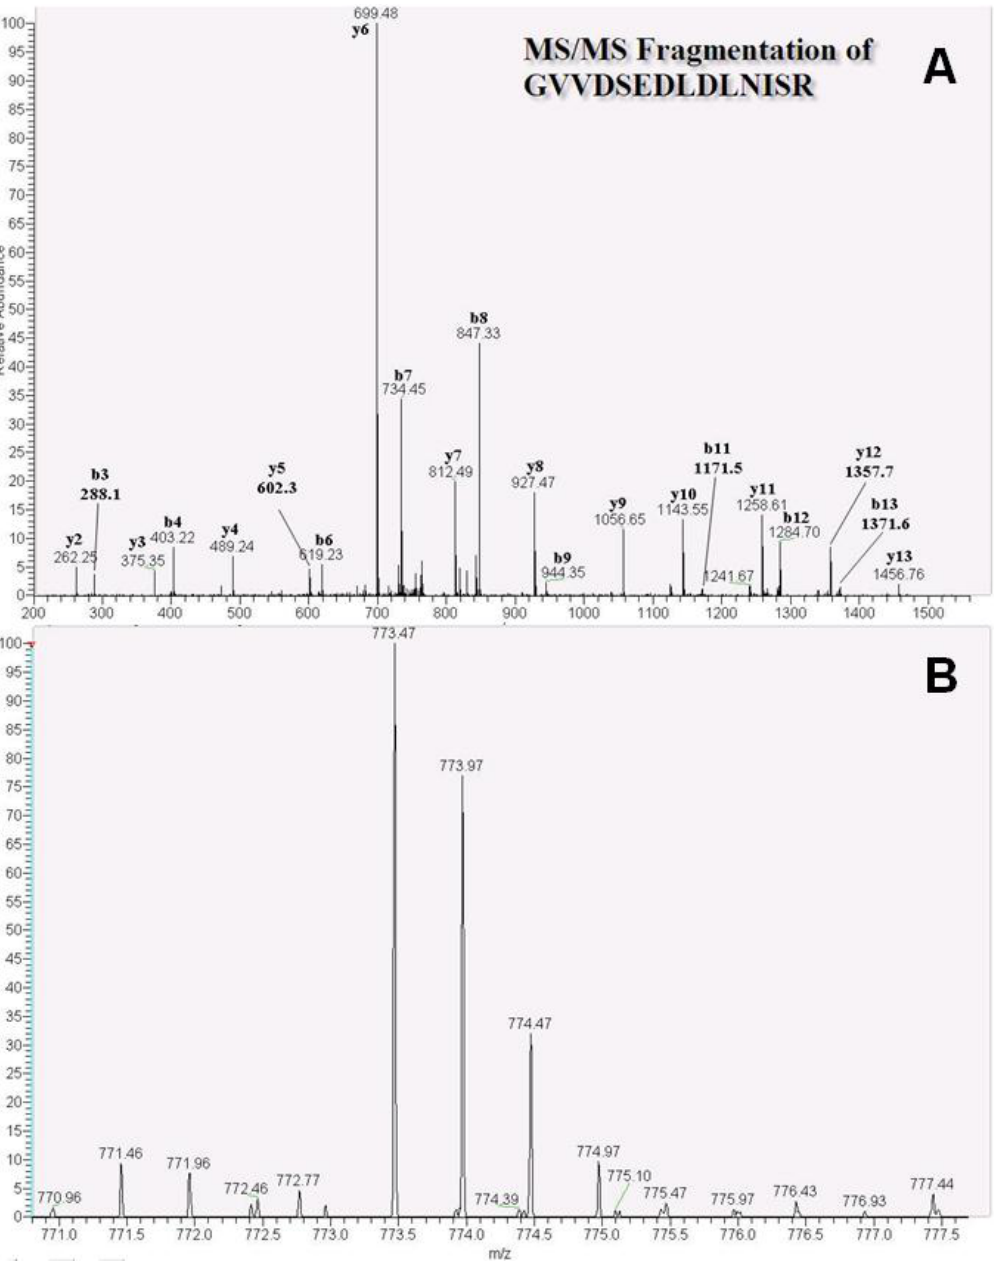
Figure 4. MS and MS/MS spectra of the heat shock protein HSP 90-beta peptide GVVDSEDLDLNISR. ( A ) MS/MS fragmentation of GVVDSEDLDLNISR ( m / z 773.47, 2 + charge), showing b- and y-ion patterns; ( B ) Formaldehyde- D 2 labeled peptide ( m / z 773.47) and formaldehyde- H 2 labeled peptide ( m / z 771.46) were co-eluted using HPLC and had differing intensities for protein